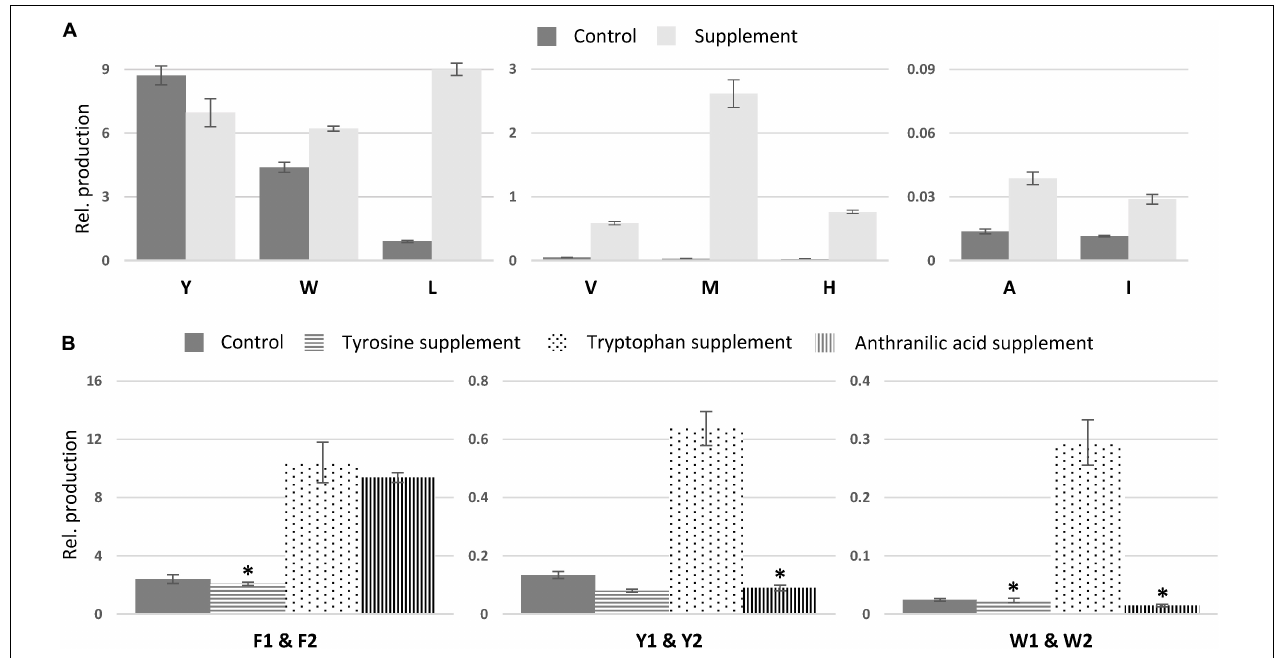
FIGURE 7 | Relative production of asperphenamate and asperphenidine analogs. (A) Relative production of asperphenamate amino acid analogs in control and corresponding amino acid supplement media. (B) Production of asperphenidines F, Y, and W in control, tyrosine, tryptophan and anthranilic acid supplemented media. Error bars show standard deviation. All data, except the ones marked with asterisk, indicate statistically significant differences compared to the control ( p <